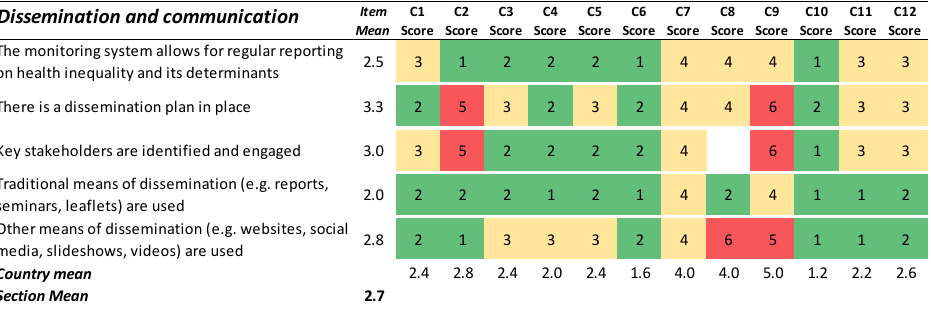
Figure 4. Results for the section ‘Dissemination and Communication’. Green cells (scores 1–2) indicate agreement with the statement. Yellow cells (scores 3–4) indicate partial agreement/disagreement, and red cells (scores 5–6) indicate the most challenging preconditions for an ideal HIMS.